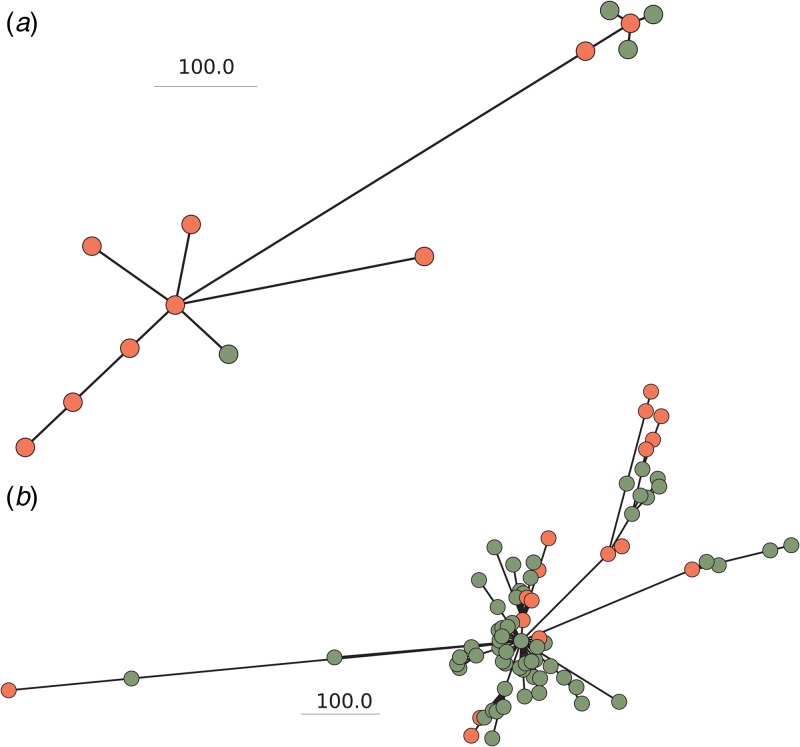
Grape trees of carrier (green) and invasive (red) isolates of N. meningitidis for (a) cc11 (n = 4 carriage isolates; n = 7 invasive isolates) and (b) cc23 (n = 60 carriage isolates; n = 17 invasive isolates). In A, upper right corner represents genogroup C and lower left corner genogroup W. cc, clonal complex.